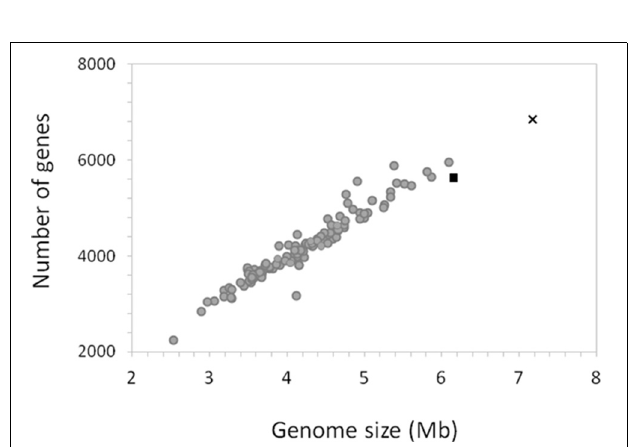
FIGURE 4 | Growth of La 6 wild-type strain (black triangles), strain XoxF − (red triangles) or no inoculum controls (white circles) on 5 mM methanol initial concentration (A) and 5 mM ethanol initial concentration (B) . Dashed lines in (A) represent methanol headspace concentrations. All conditions contained 5 µ M lanthanum. Error bars show standard error of three replicate cultures.